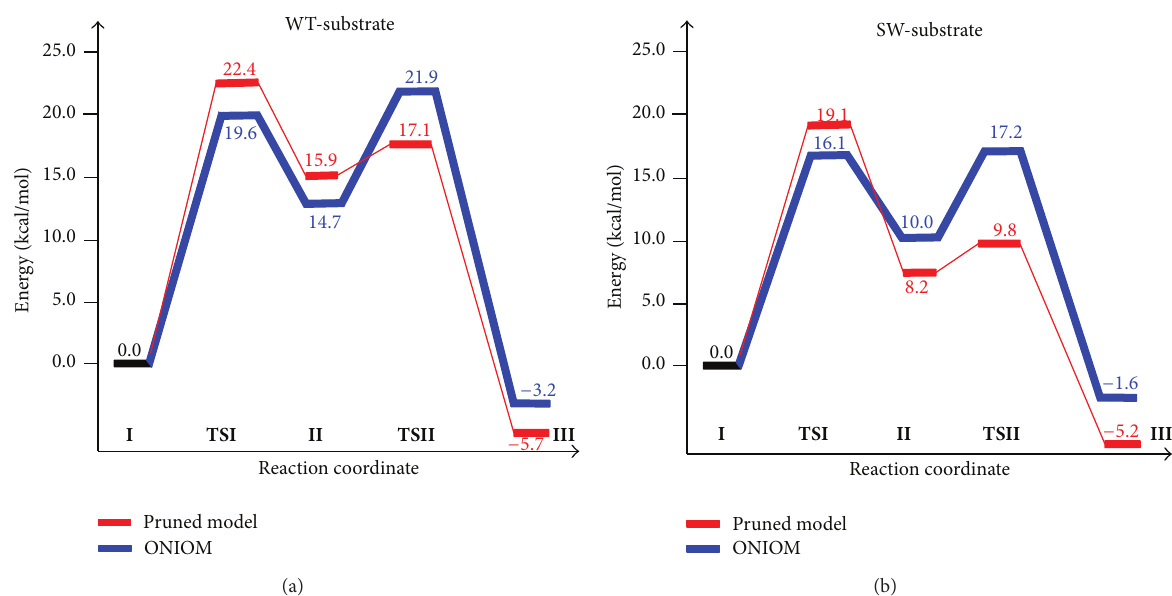
Figure 4: Computed barriers for the WT- and SW-substrate using pruned models (with the DFT method) and entire protein (with the ONIOM (QM/MM)